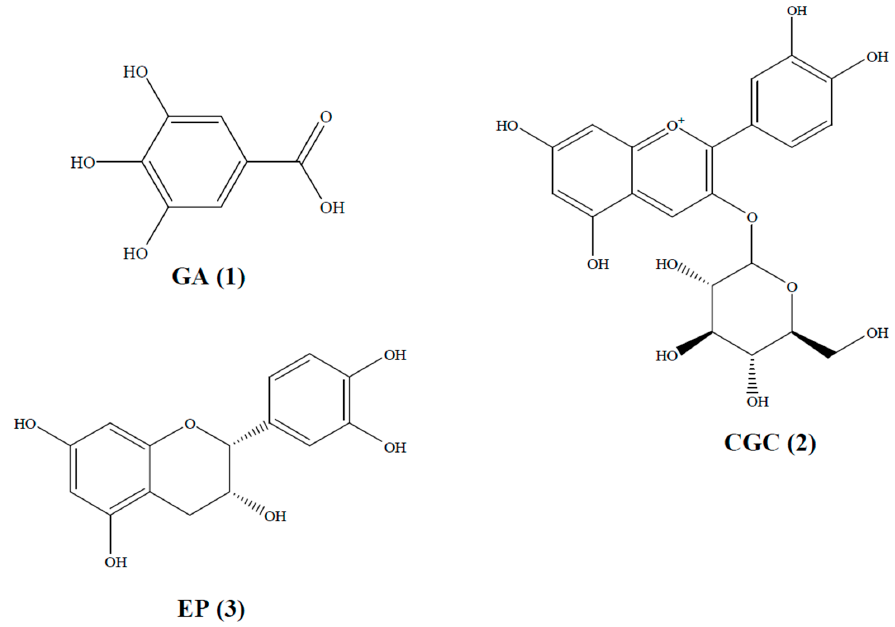
Figure 2. The molecular structures of three SBM extracts. GA: gallic acid, CGC: cyanidin-3- O -glucoside chloride, EP: epicatechin.